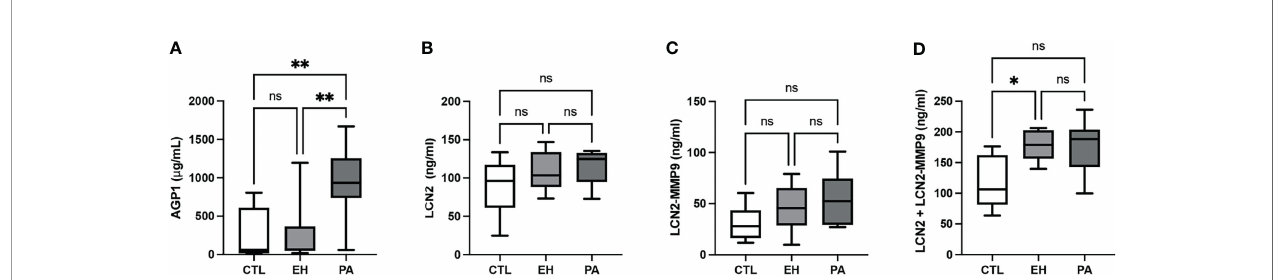
FIGURE 4 | Determination of serum AGP1, LCN2, LCN2-MMP9, and in PA subjects. (A) Serum AGP1 concentration (µg/mL). We detected higher levels of AGP1 in PA subjects in both EH and CTL groups. (B) Serum LCN2 concentration (ng/mL). LCN2 concentration was similar between groups (C) Serum LCN2-MMP9 concentration. LCN2-MMP9 concentration was similar between groups (ng/mL). (D) Serum LCN2 + LCN2-MMP9 concentration (ng/mL). Serum levels of LCN2 + LCN2-MMP9 were higher in EH subjects in the CTL group. LCN2 + LCN2-MMP9 concentration was similar between PA and EH subjects and PA and CTL subjects.